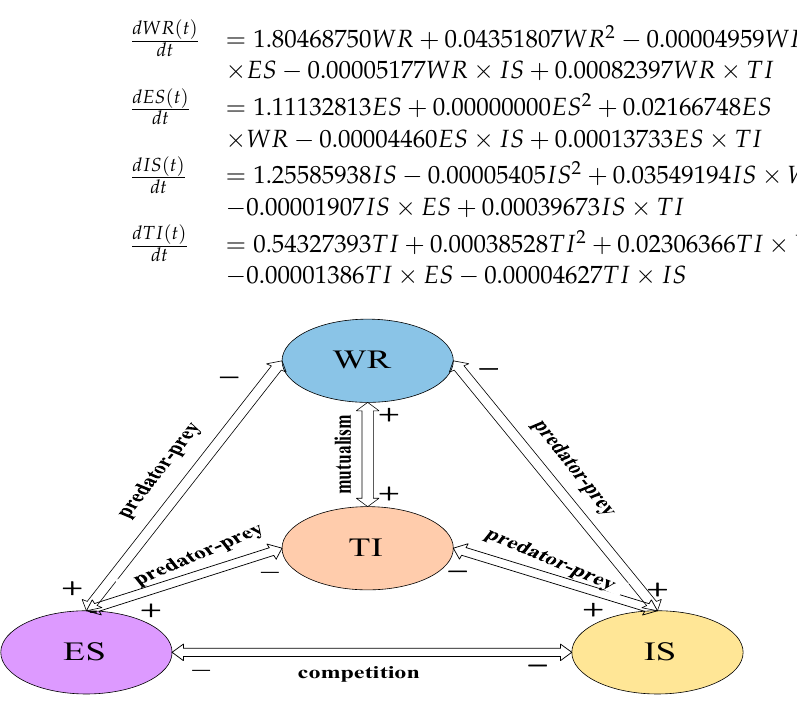
According to the data of the four systems in Tianjin from 2015 to 2019, Equation (33) and Figure 5 are obtained through relevant calculations.